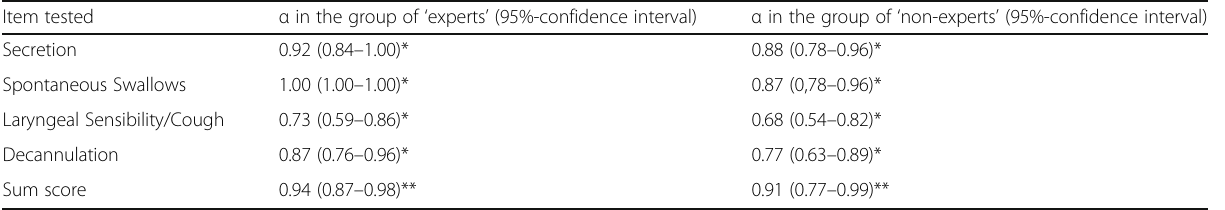
Table 1 Inter-rater reliability in a group of ‘ experts ’ and ‘ non-experts ’ (*Krippendorff ‘ s α ; **Cronbach ’ s α ) Item tested